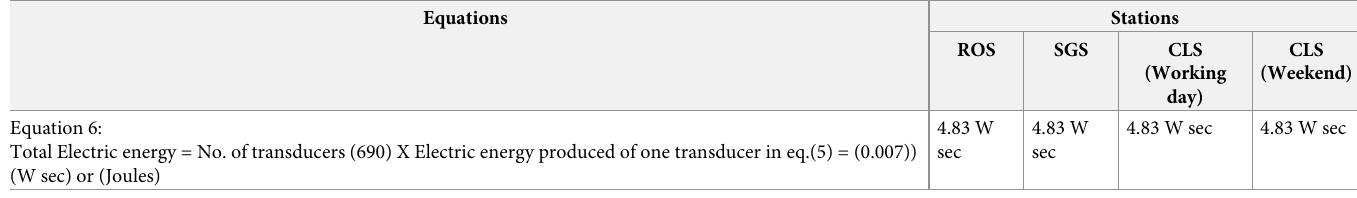
Table 15. The Total Electric energy produces by 690 transducers that are used to cover the proposed area at the bus stop at each of the three selected stations pre- sented earlier in Fig 14 and using equation (6). Equations